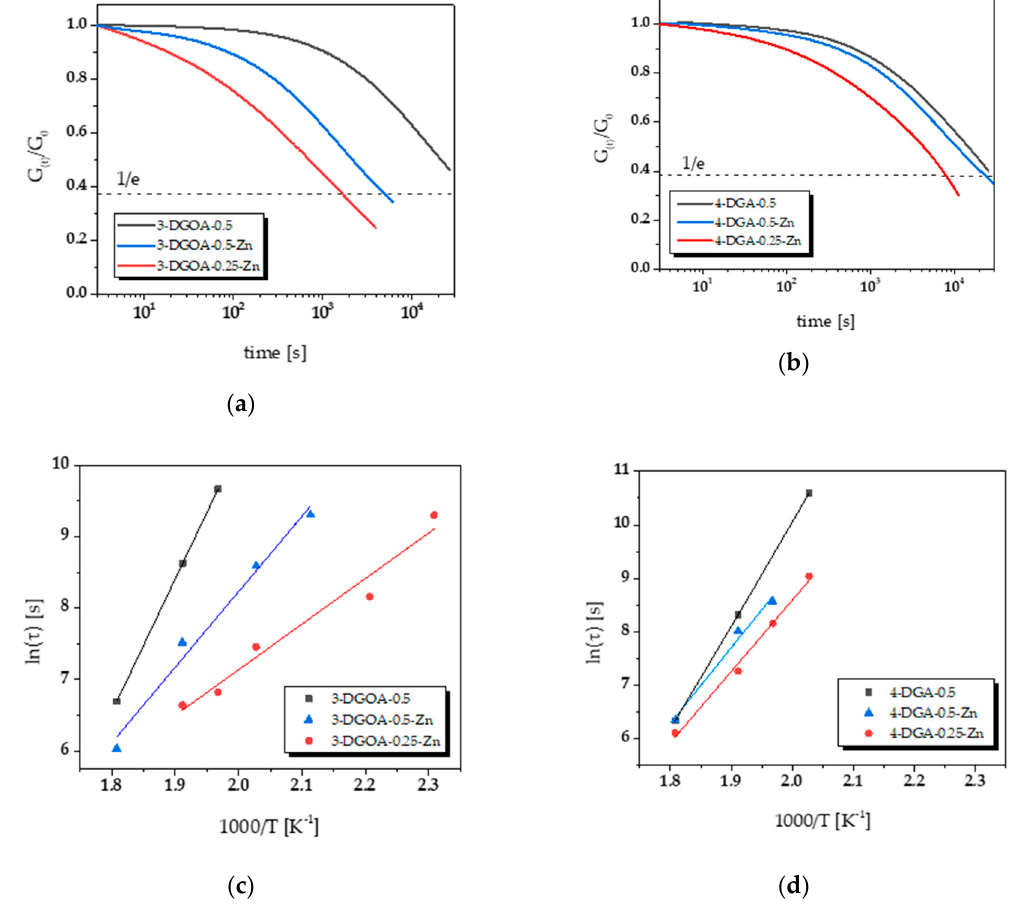
Figure 5. Normalised stress relaxation curves of epoxy-anhydride networks from ( a ) 3-DGOA and ( b ) 4-DGA obtained at 220 °C. Arrhenius plot of the measured relaxation times from epoxy-anhydride networks obtained with ( c ) 3-DGOA and ( d ) 4-DGA.